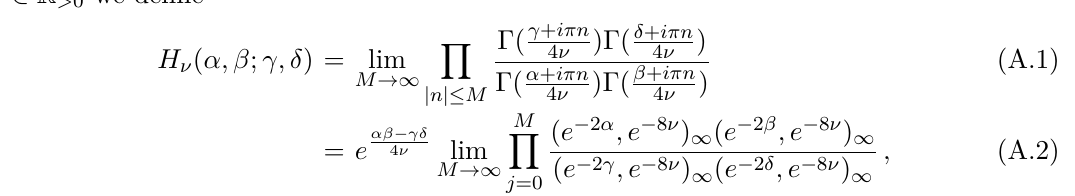
which can be done in the 2